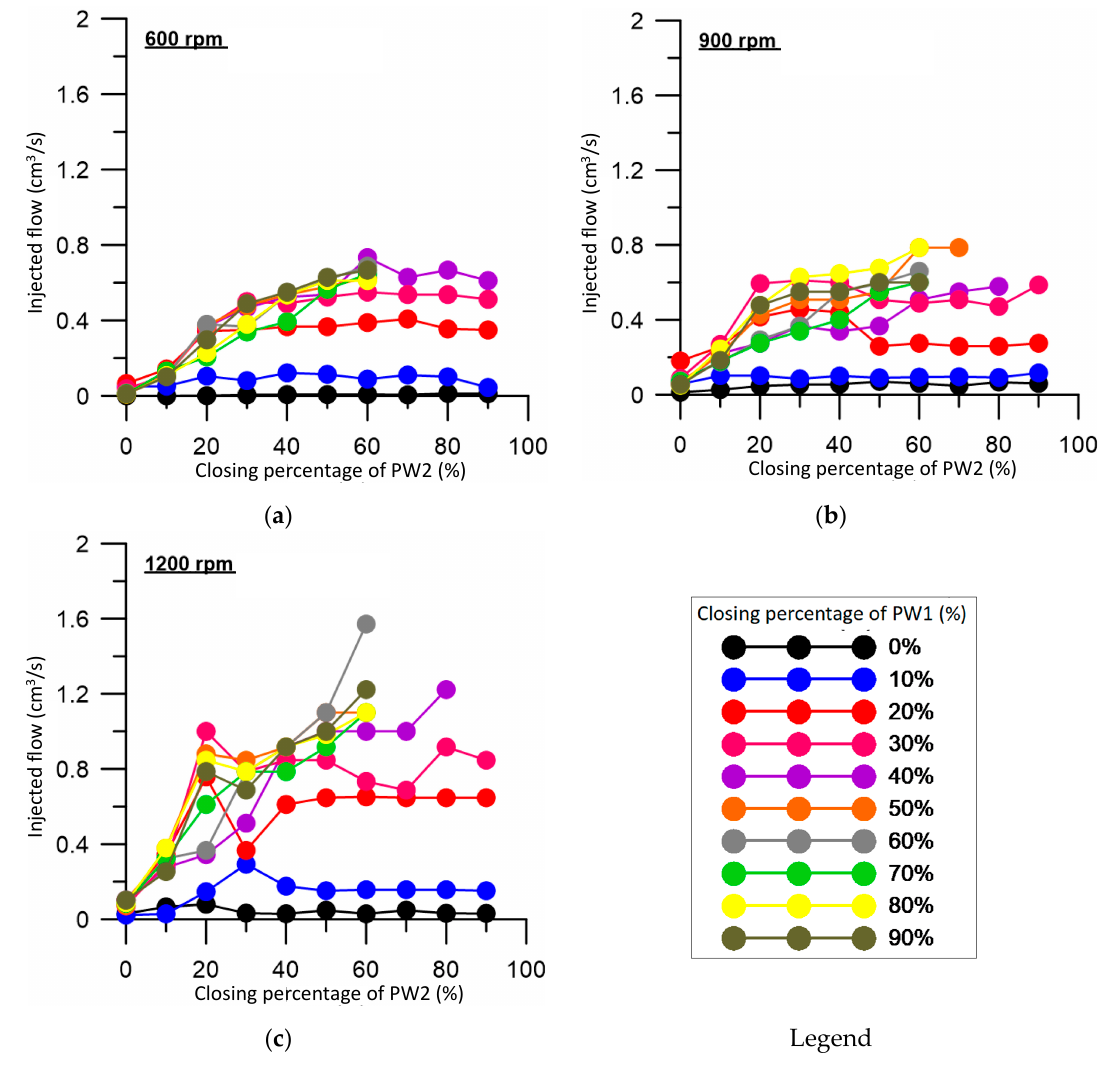
Figure 3. Injected flow: ( a ) 600 rpm HPP rotational speed; ( b ) 900 rpm HPP rotational speed; and ( c ) 1200 rpm HPP rotational speed.